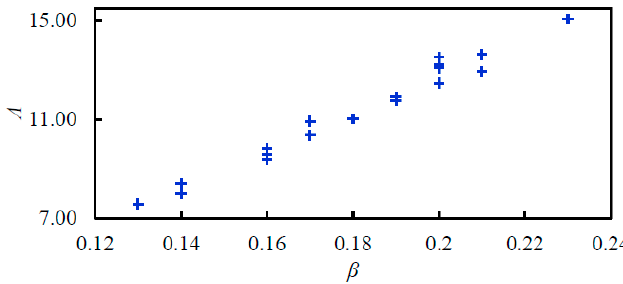
Figure 4. Increasing figure between 𝛽 and 𝛬 for constant background helium pressure 𝑝 = 20.2 Pa .